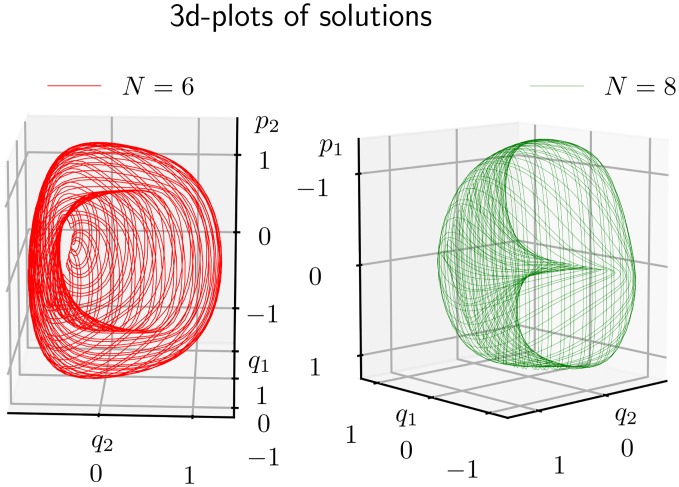
A quasi-periodic orbit z(t) for times 0 ≤ t ≤ 2000, found by the KiMoKi solvers of order N = 6 (left panel) and order N = 8 (right panel) with timestep τ = 0.1, projected to respectively the (q1, q2, p2) (left) and (q1, q2, p1) (right) subspaces.The initial condition z0 = (0.1, 0, 0.1, 1.40709), with H0 = 1, C3⊥ = −6.45412. The viewing angle is set to (ϑ, φ) = (15, −87) (left), respectively (ϑ, φ) = (−128, 133). Here ϑ is the elevation angle (elev) and φ the azimuth angle (azim).